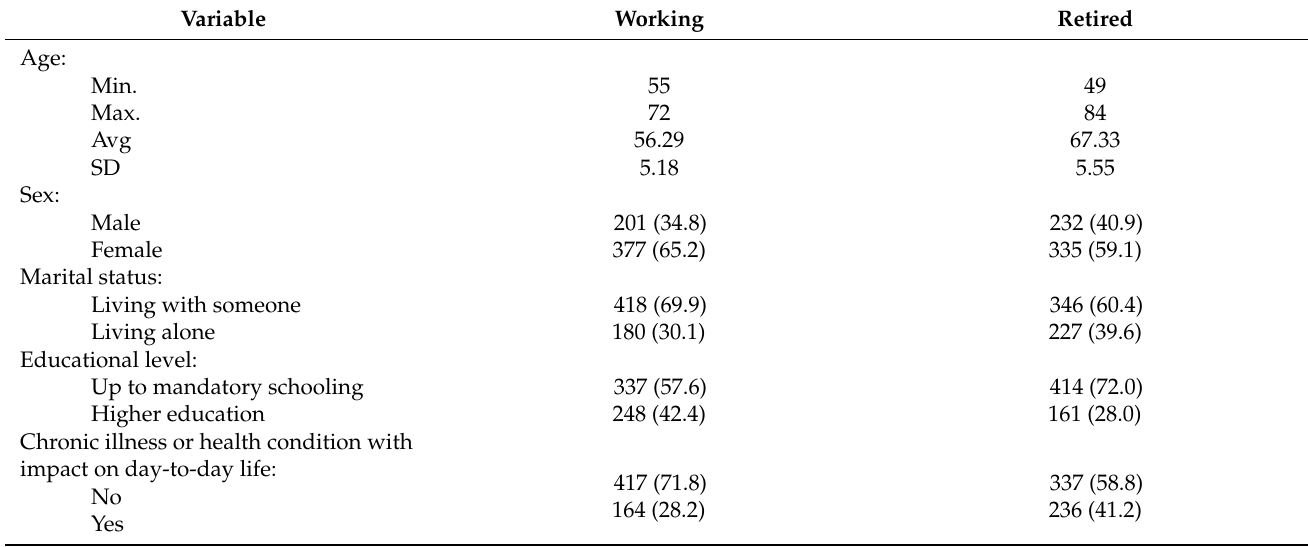
Table 2. Sample characteristics concerning occupational status (descriptive statistics).